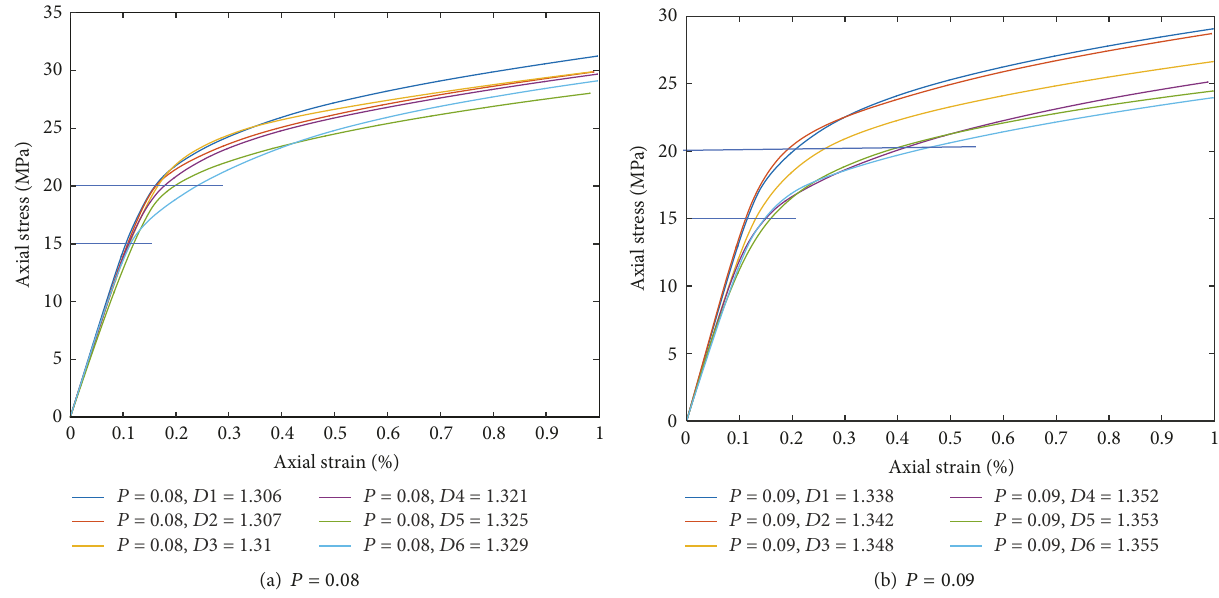
Figure 6: The stress-strain curve of the different fractal dimensions under the same porosity.